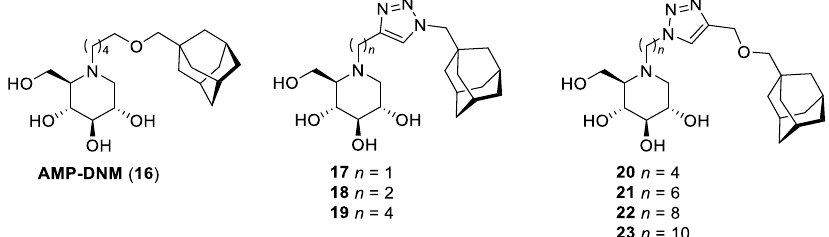
Figure 6. AMP-DNJ and the corresponding triazole-containing derivatives [98].